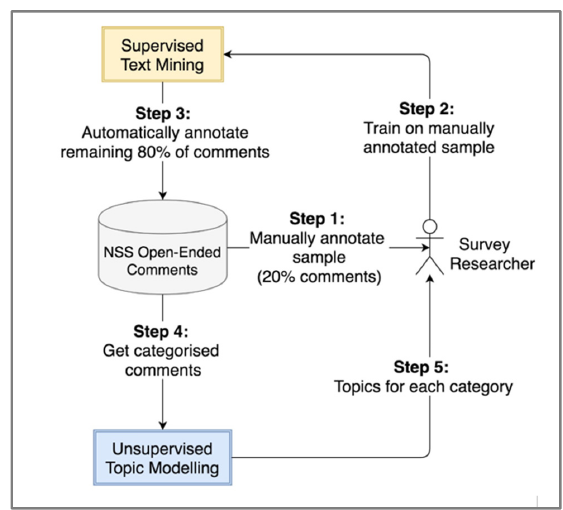
Figure 4. Architecture of the proposed text-mining method to identify automatically the problem statements in the NSS free-text